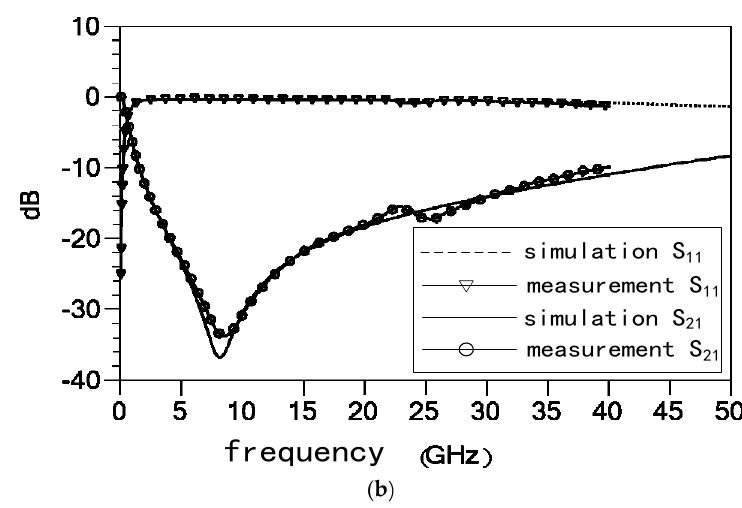
Figure 7. Measurement and simulation S parameters results of the proposed high-capacitance-ratio RF MEMS switch. ( a ) Up state; ( b ) Down state.